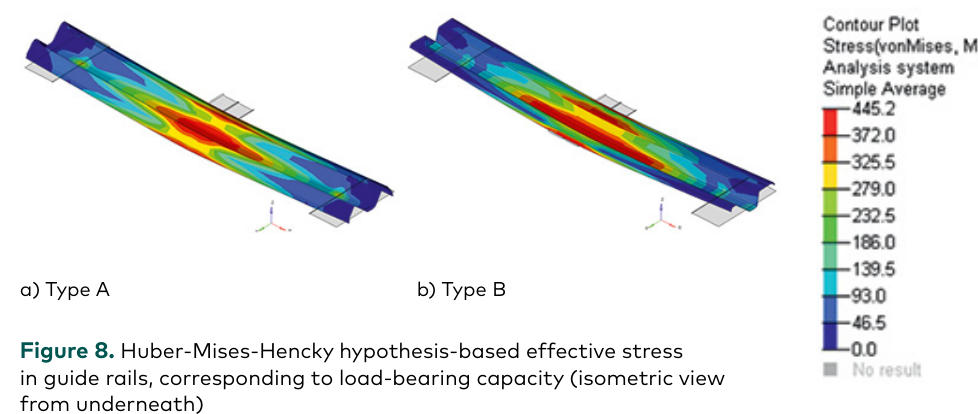
Figure 8. Huber-Mises-Hencky hypothesis-based effective stress in guide rails, corresponding to load-bearing capacity (isometric view from underneath)